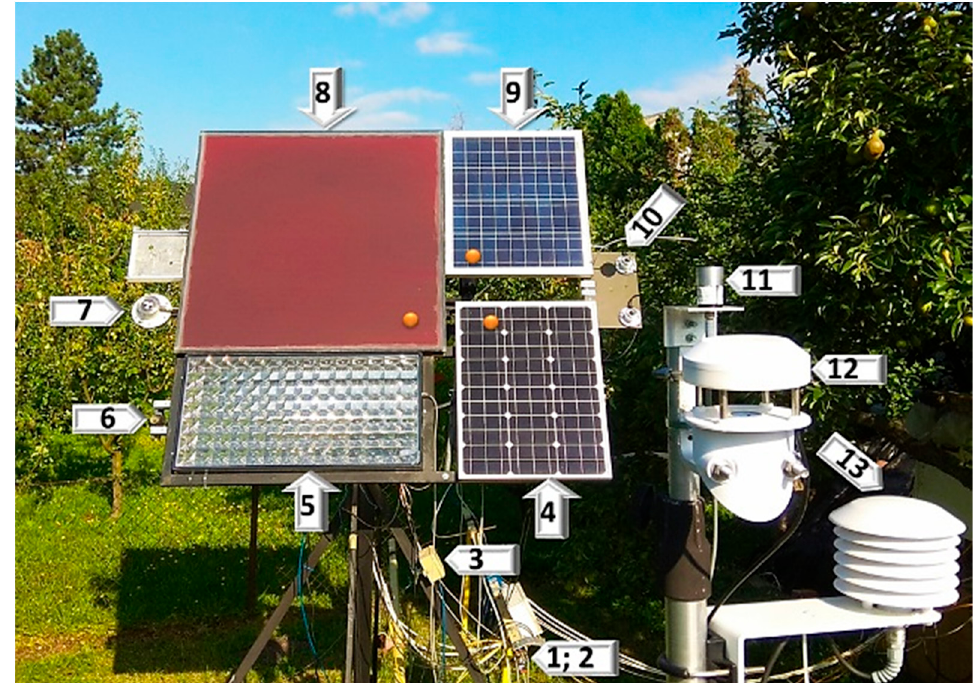
Figure 3. The measuring station in Keszthely (1, HYTE-ANA-1735 humidity module [measuring air humidity]; 2, Pt 100 sensor; 3, manual/automatic tracking control unit; 4, m-Si module; 5, CPV module; 6, photosensors; 7, Eppley Black and White pyranometer; 8, a-Si module; 9, p-Si module; 10, Hukseflux LP02 pyranometers; 11, EMS 11 Silicon PV detector; 12, DS-2 Sonic anemometer; 13, OTT TRH relative humidity sensor; Orange dot: Pt 100 sensors).